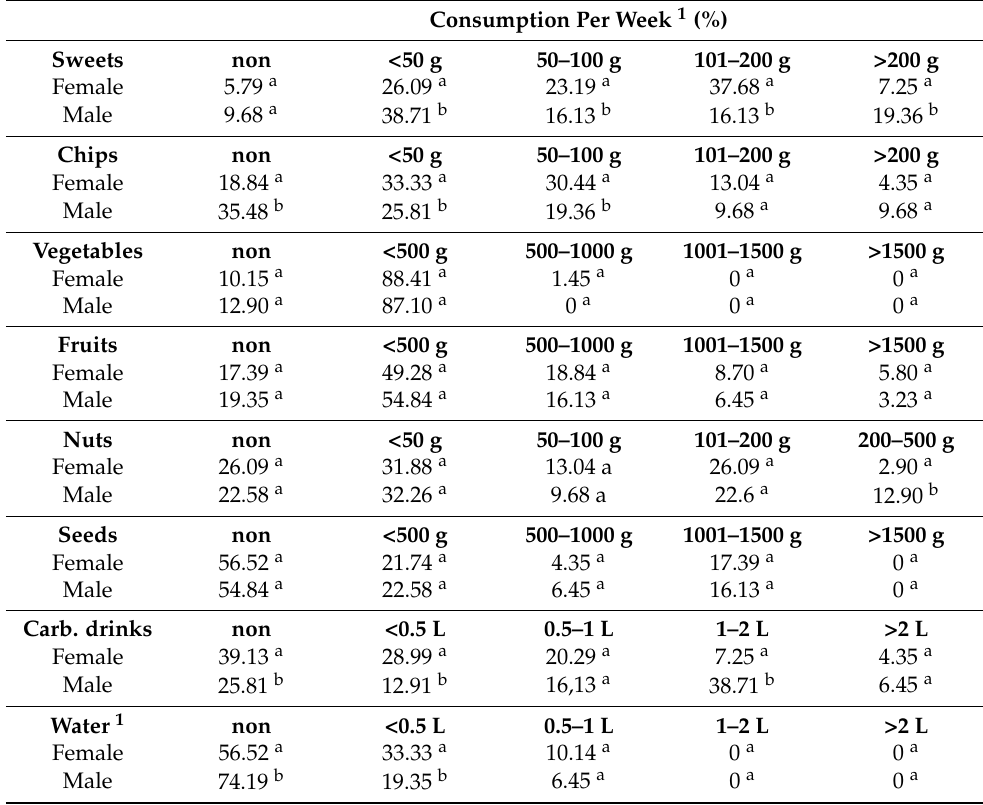
Table 3. Frequency of consumption of certain foods and